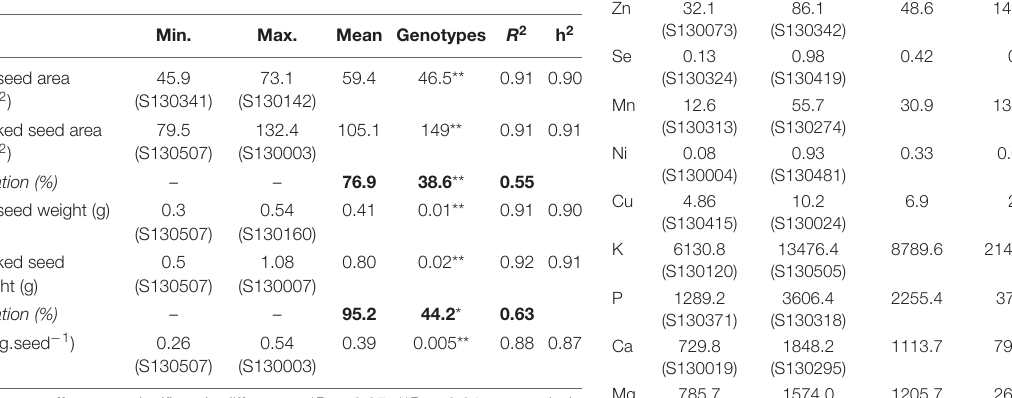
TABLE 3 | Range, mean, mean squares, and R 2 , and heritability (h 2 ) of dry seed area, soaked seed area, area variation, dry seed weight, soaked seed weight, weight variation, and hydration capacity recorded for all tested chickpea genotypes. Min.